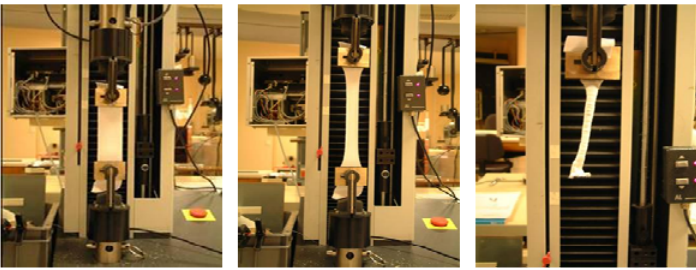
Figure 5. Tensile apparatus of pre-impregnated composite fabric specimen.